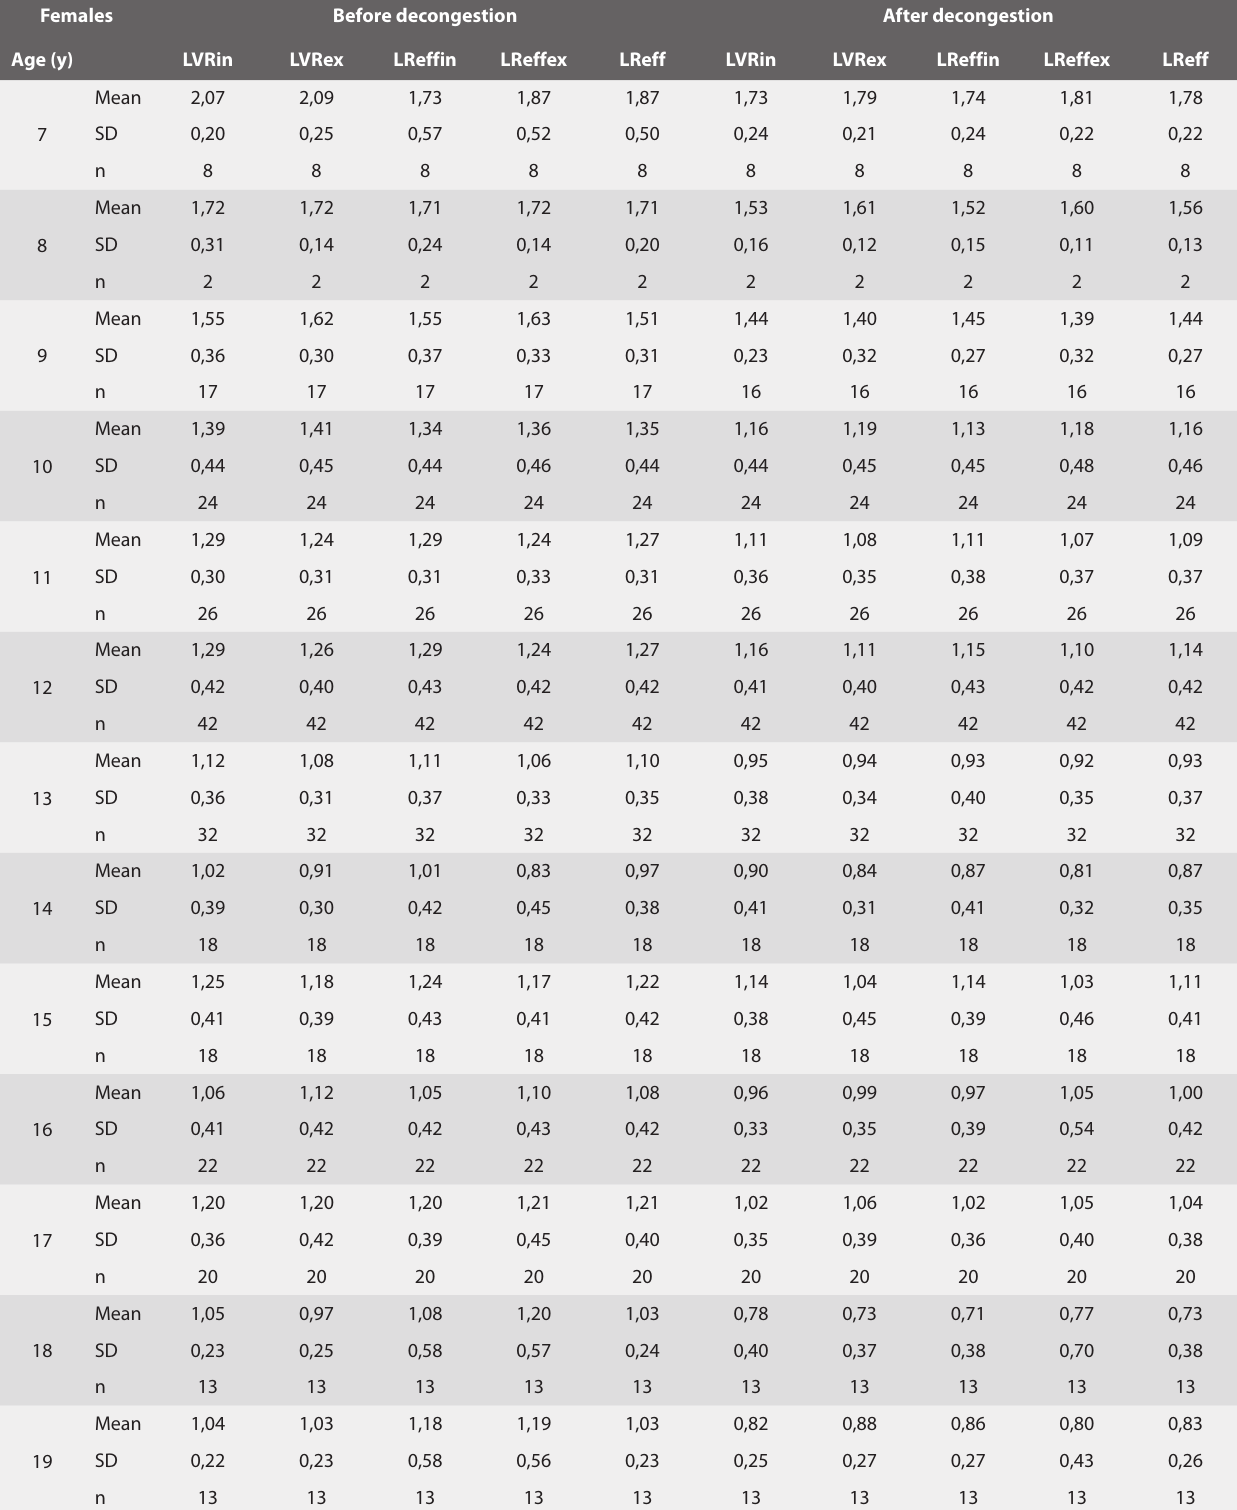
Table 3B. Descriptive statistics for resistances at different ages in